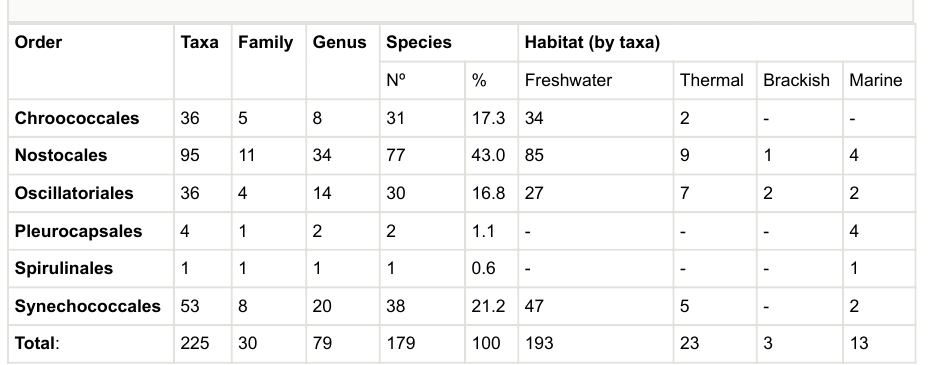
Cyanobacteria taxa richness of the Azores